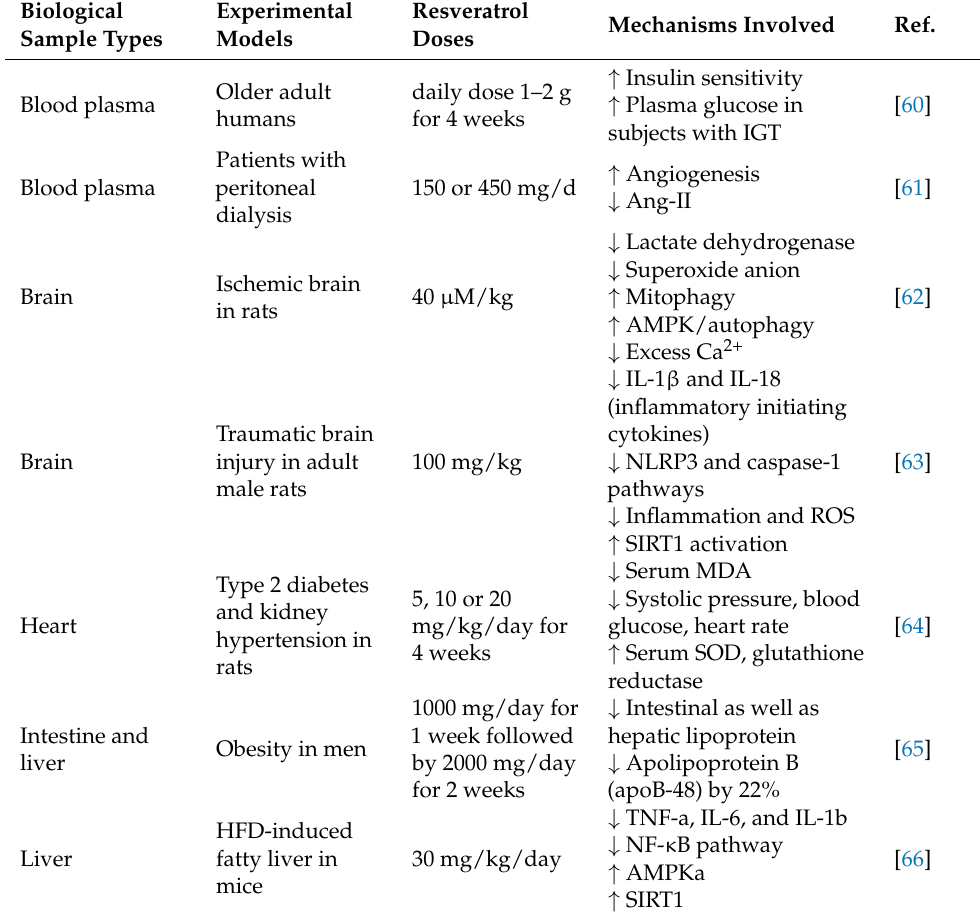
Table 1. Pharmacological effects of resveratrol on different mechanisms involved in the aging process in various organs or cells or